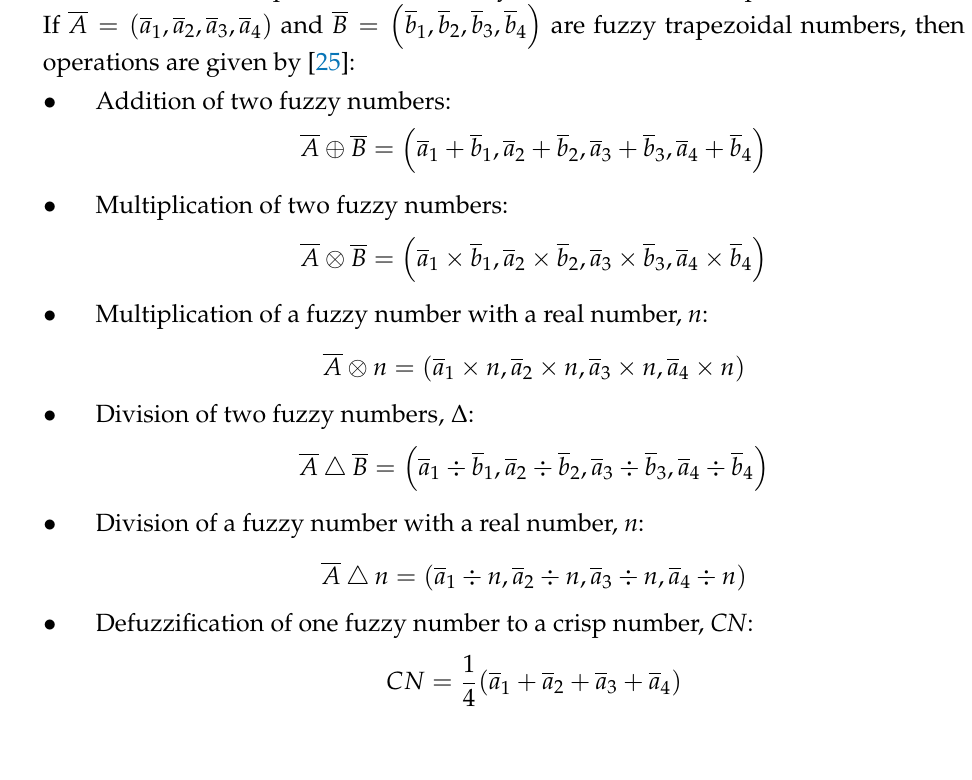
Figure 3. Schematic representation of a trapezoidal fuzzy number. Mathematical operations with fuzzy numbers also have particular characteristics. If